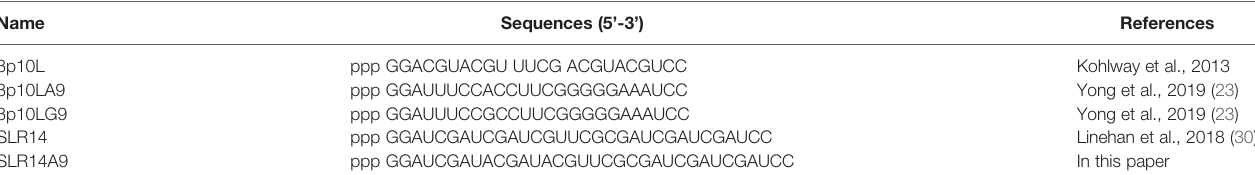
TABLE 1 | List of RNAs.